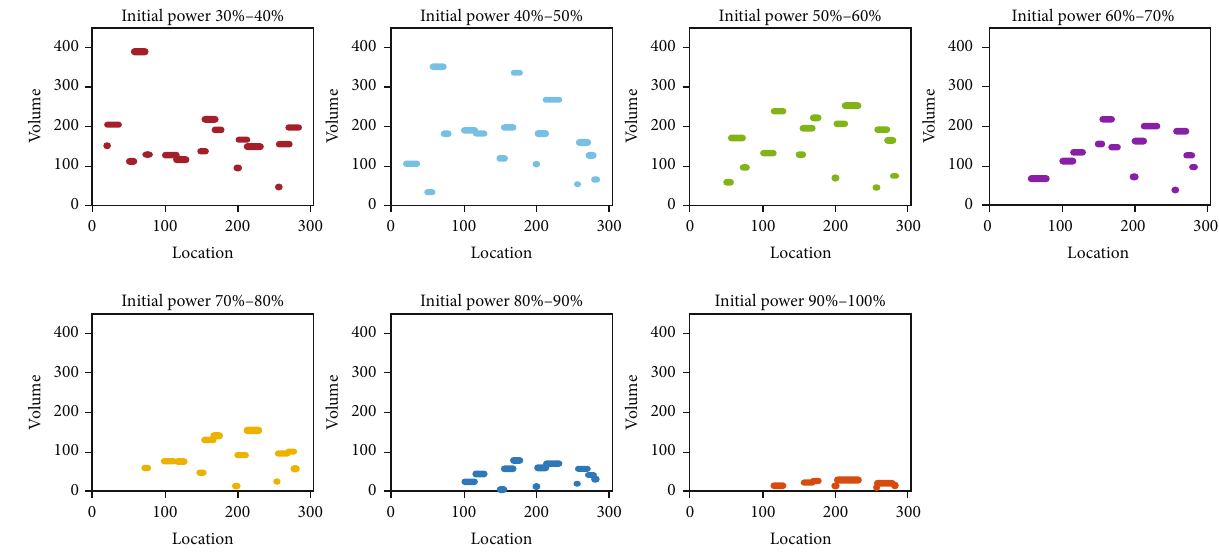
Figure 11: Charging strategies for EVs with varying initial battery Table 4: Result comparison (number of lanes). Location range